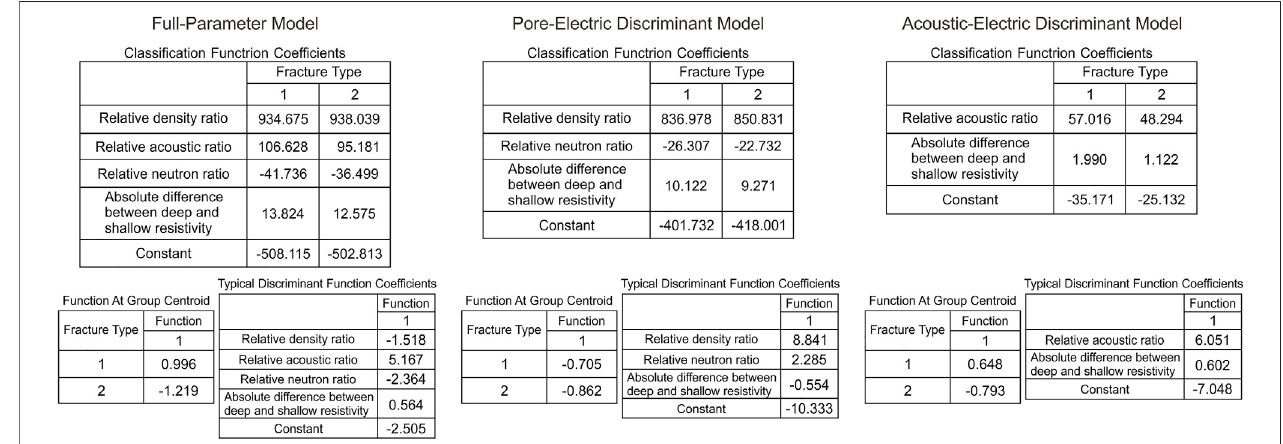
FIGURE 3 | The establishment of the fracture multivariate discriminant model and the typical discriminant functions.